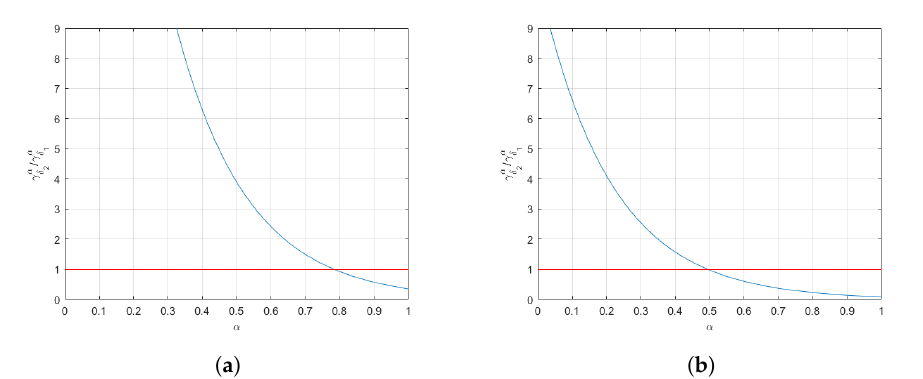
Figure 2. β -dimensions of the middle- ξ Cantor sets. ( a ) The numerical result shows α ≈ 0.77 for C ξ setting ξ = 1/5; ( b ) the numerical result shows α ≈ 0.5 for C ξ setting ξ = 1/2.